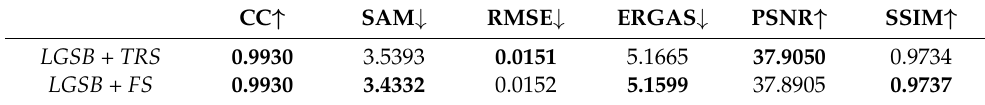
Table 3. Quantitative analysis of feedback structure and traditional recursive structure.